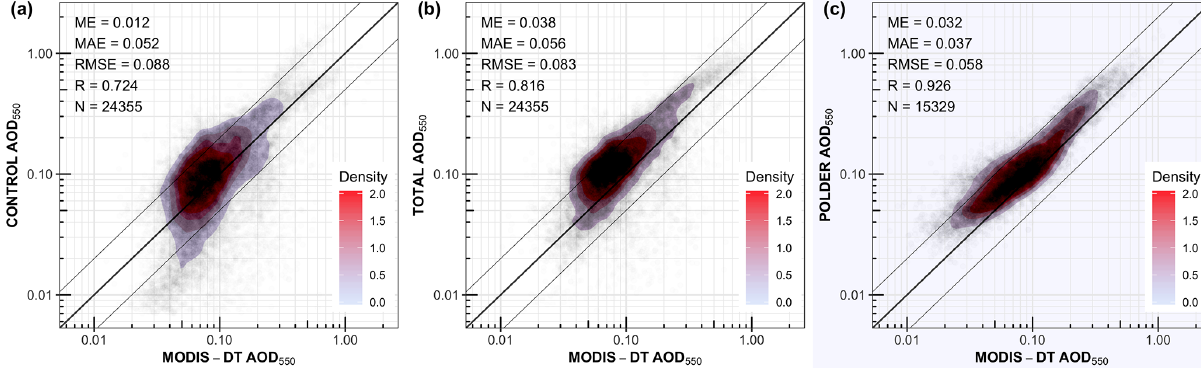
Figure 18. The AOD 550 of MODIS-DT over ocean against the CONTROL, TOTAL and POLDER experiments (a–c)